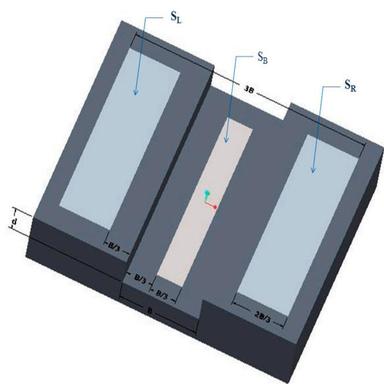
Indication of the evaluation areas for areal standard artefact.